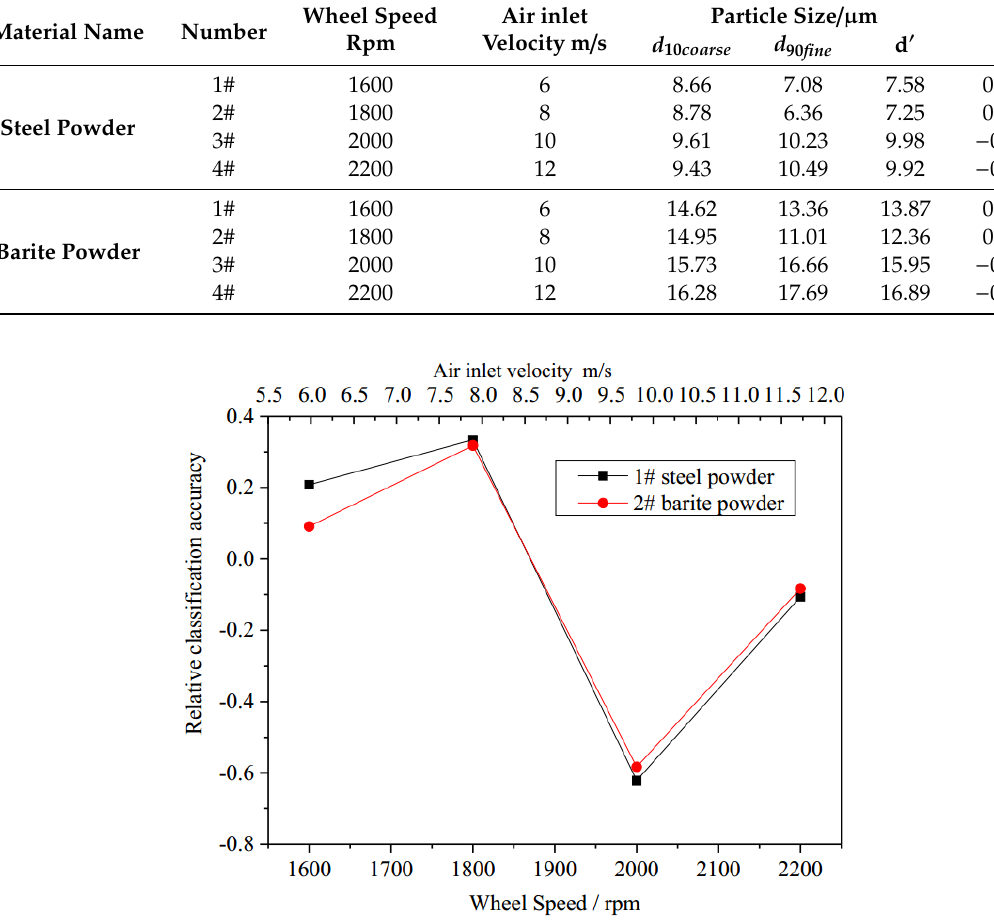
Figure 11. Comparison of relative classification accuracies for different process parameters.